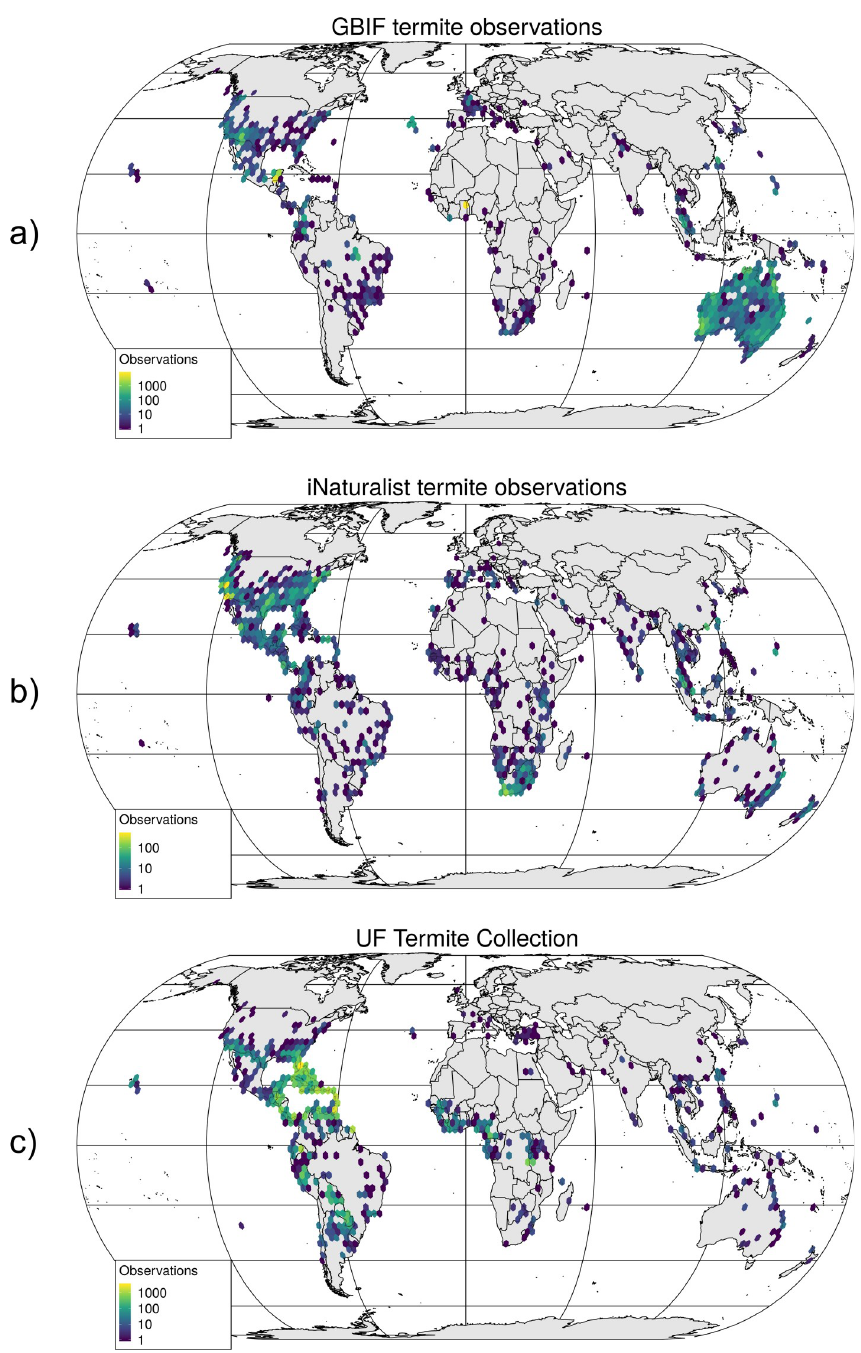
Fig 2. Geographic distribution of termite records in GBIF (a), iNaturalist (b), and the UFTC (c). Colors indicate the number of termite records found in 2.5˚ hexagon grid cells across the globe. ( Reticulitermes , n = 939), very large ( Zootermopsis , n = 351), build conspicuous nests ( Nasuti- termes , n = 187), or forage on the surface of the soil ( Gnathamitermes , n = 77, and Tenuirostri- termes , n = 43) (Table 2). All other genera had fewer than 40 observations, and many had 1 to